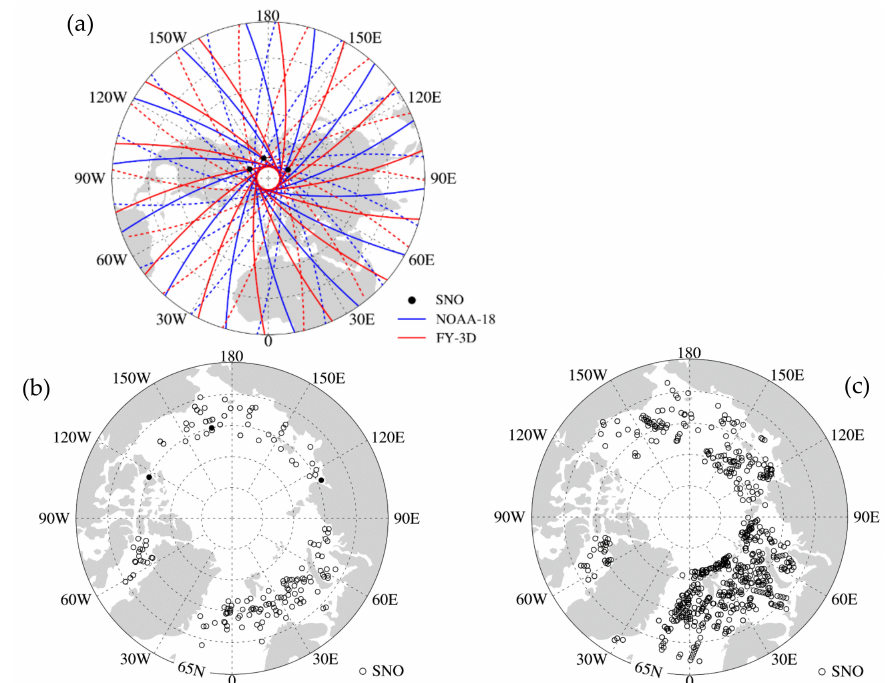
Figure 3. ( a ) Ascending (solid) and descending (dashed) nodes from NOAA-18 (blue curves) and FY-3D (red curves) swaths on 1 January 2020 shown under a north-polar stereographic projection, ( b ) all SNO points between FY-3D and NOAA-18